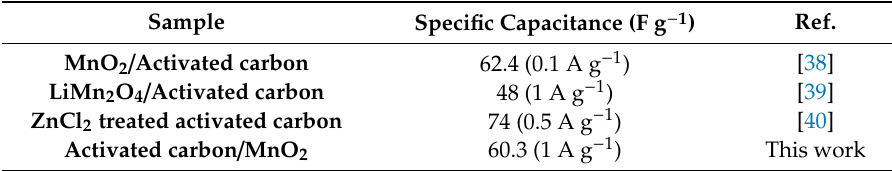
Figure 4. ( a ) Galvanostatic charge/discharge curves of the prepared composites at 1 A g − 1 ; ( b ) galvanostatic charge/discharge curves of the AM1 composite electrodes at different current densities (1 − 5 A g − 1 ); ( c ) cyclic voltammograms of the prepared samples at a scan rate of 100 mV s − 1 ; ( d ) cyclic voltammograms of the AM1 composite electrodes at different scan rates; ( e ) comparison of the specific capacitances of AC, MO and AM composites; and ( f ) cycling performance of AM1 composite electrodes at 100 mV s − 1 for 5000 cycles. Table 3. Comparison of the specific capacitance of this work with that of other literature.